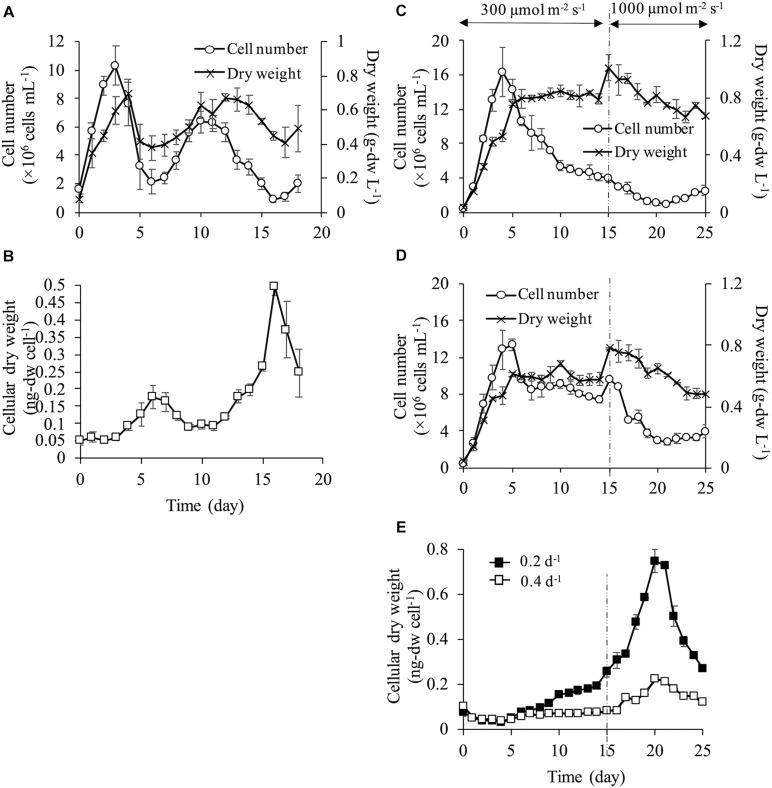
Growth characteristics at each dilution rate. Cell number and dry weight (A) and cellular dry weight (B) at dilution rate of 0.1 d–1 under 300 μmol m–2 s–1. At dilution rates of 0.2 and 0.4 d–1, light intensity was set at 300 μmol m–2 s–1 during days 0–14, and at 1,000 μmol m–2 s–1 during days 15–25. Cell number and dry weight at dilution rate of 0.2 d–1
(C) and dilution rate of 0.4 d–1
(D). Cellular dry weight of dilution rates of 0.2 d–1 and 0.4 d–1
(E).